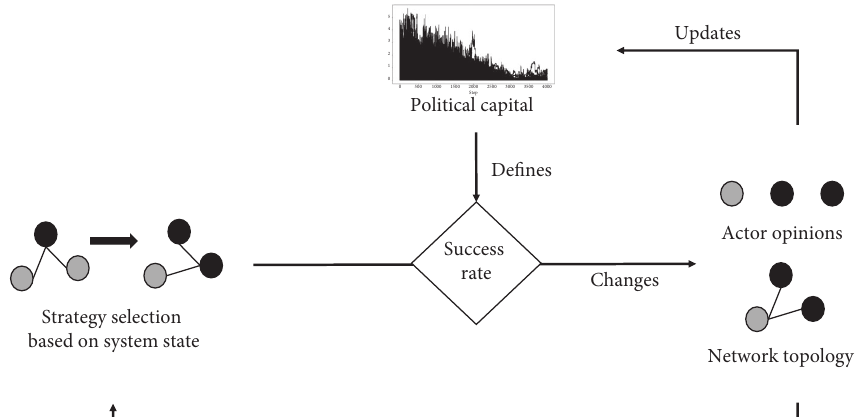
Figure 2: Model flow